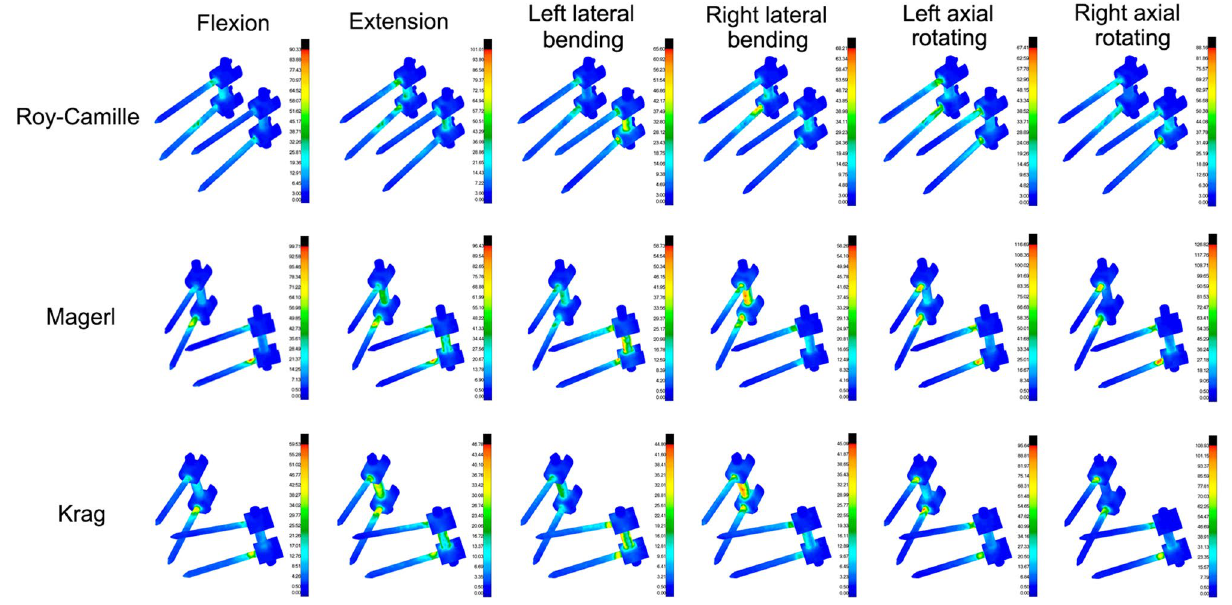
Figure 8. The stress distribution of screw-rod systems in three postoperative FE models under different conditions. According to the indicator diagram, red indicates the stress concentration area, while blue shows the stress dispersion area.